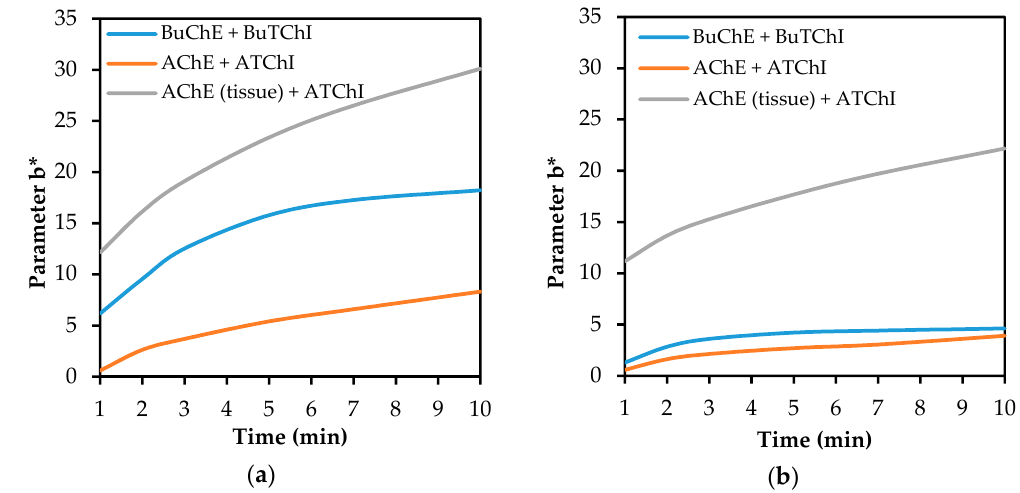
Figure 8. A comparison of the influence of the inhibition of enzyme by physostigmine (10 µg/mL) after 1 min incubation on the discoloration of the detection fabric in all tested enzyme systems, including substrate and carrier: ( a ) filter glass paper; ( b ) filter cellulose paper.